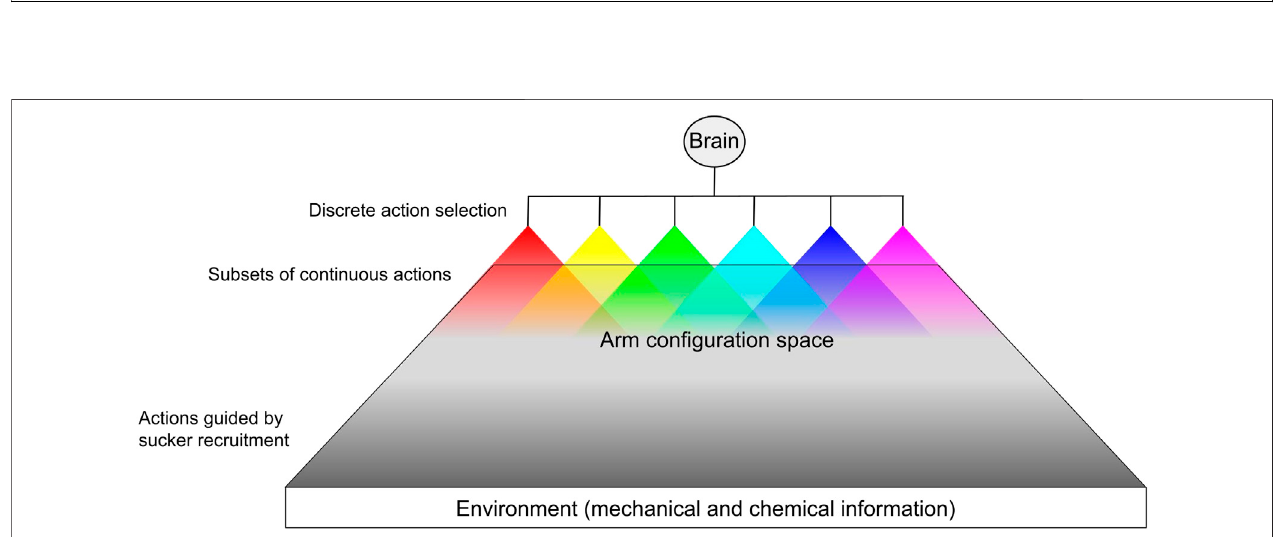
FIGURE 3 | Hypothetical pipeline of hybrid hierarchical action selection. For each arm, the brain determines an action over a discrete domain (e.g. fetch, reach, push,reject, etc.).Foreach discrete action, the armisallowed asubset ofcontinuous stereotyped actions executed basedonperipheral proprioceptive informationand sensory information from the environment. The actuation of these continuous action subsets overlap within the arm ’ s con fi guration space. Most of the arm ’ s con fi gurationspaceisdominatedbythepossiblearmshapesresultingfromsensory-guidedsuckerrecruitment(e.g.surfaceconformation).Somebehaviors,such as reach, have some continuous parameters that the brain may be able to set (Gutnick et al., 2020).